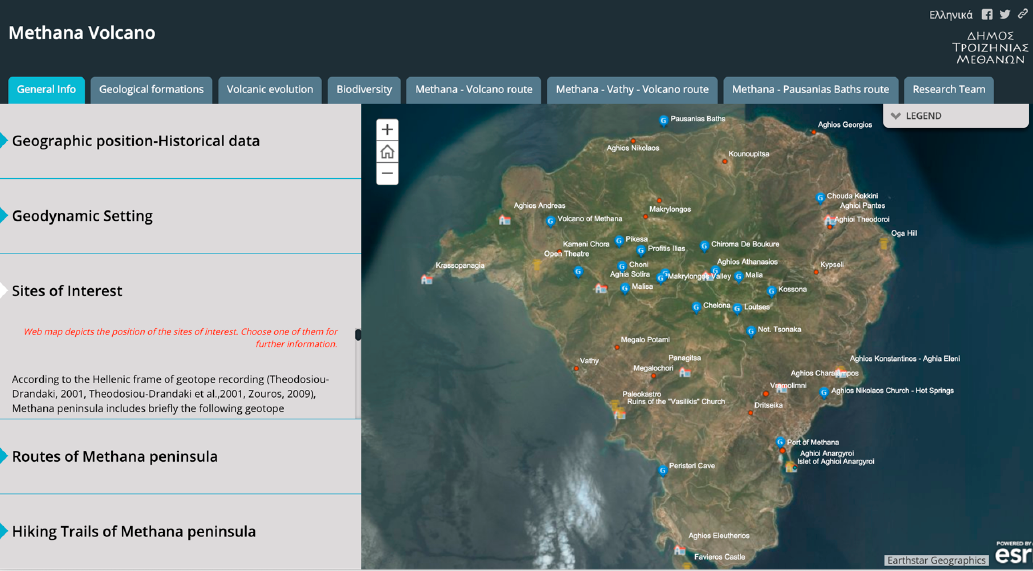
Figure 8. Screenshot of the first tab, where general information for the Methana peninsula is given. Story Map Series—Accordion layout is used, and its third tab presents the spatial distribution of most interesting points in the area (https://goo.gl/UR1a9k).